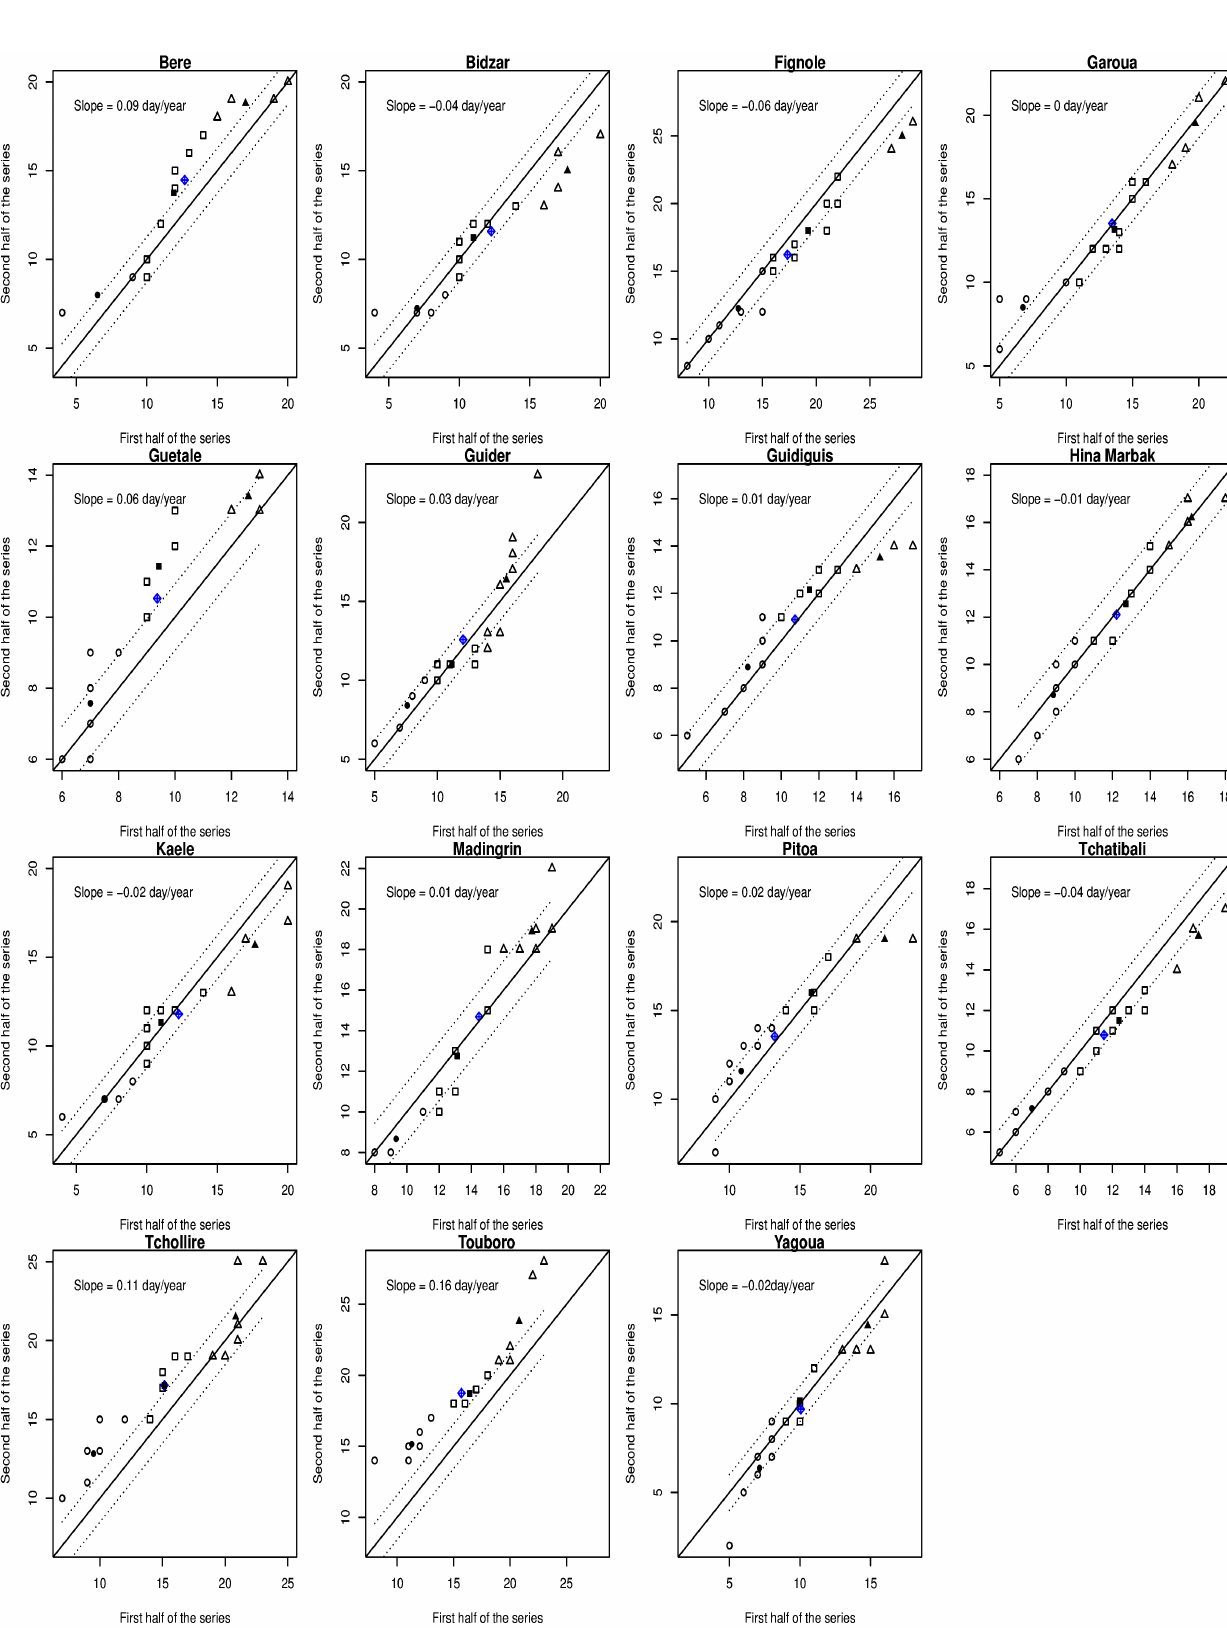
Figure 11. As in Figure 10, but for R25mm.